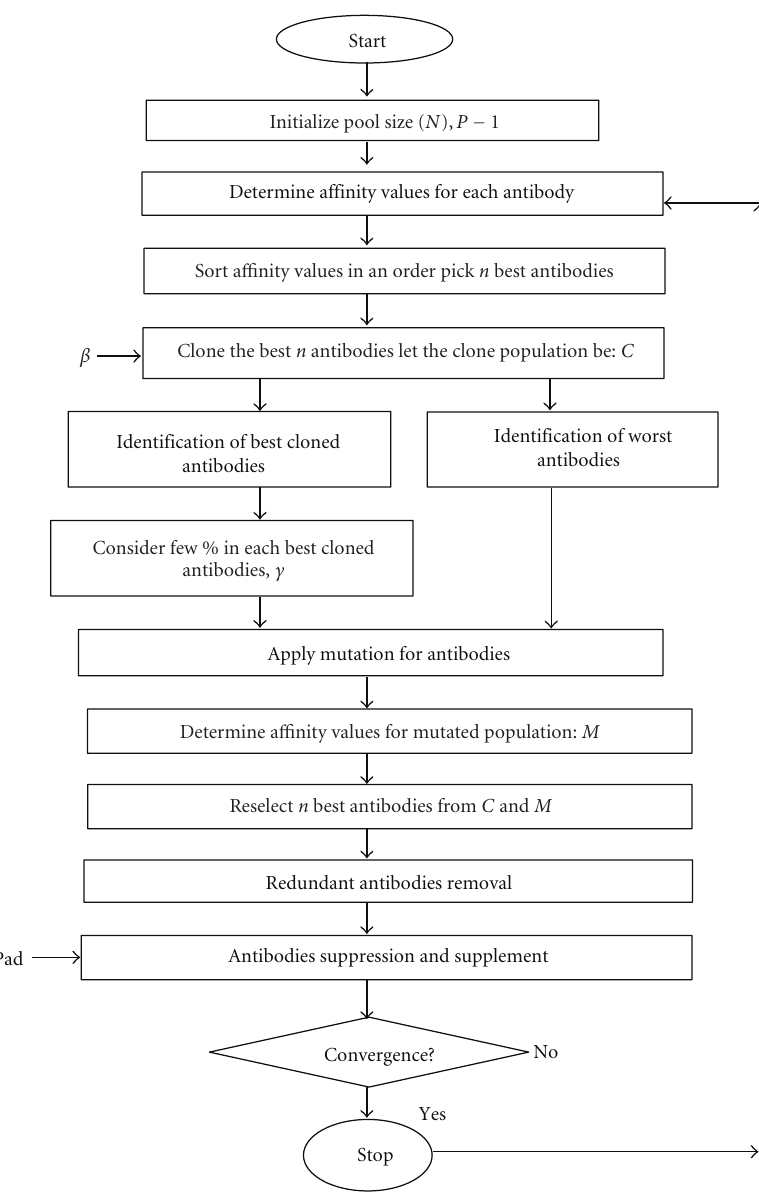
Figure 1: Basic Flow chart for FMCSA and